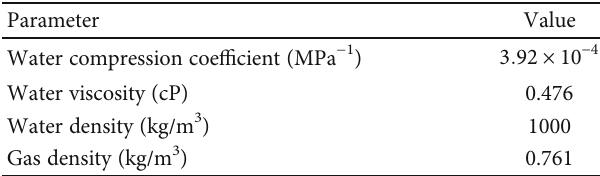
Figure 3: Concise diagram of the mechanism model. Table 1: Key parameters of the fl uid properties.